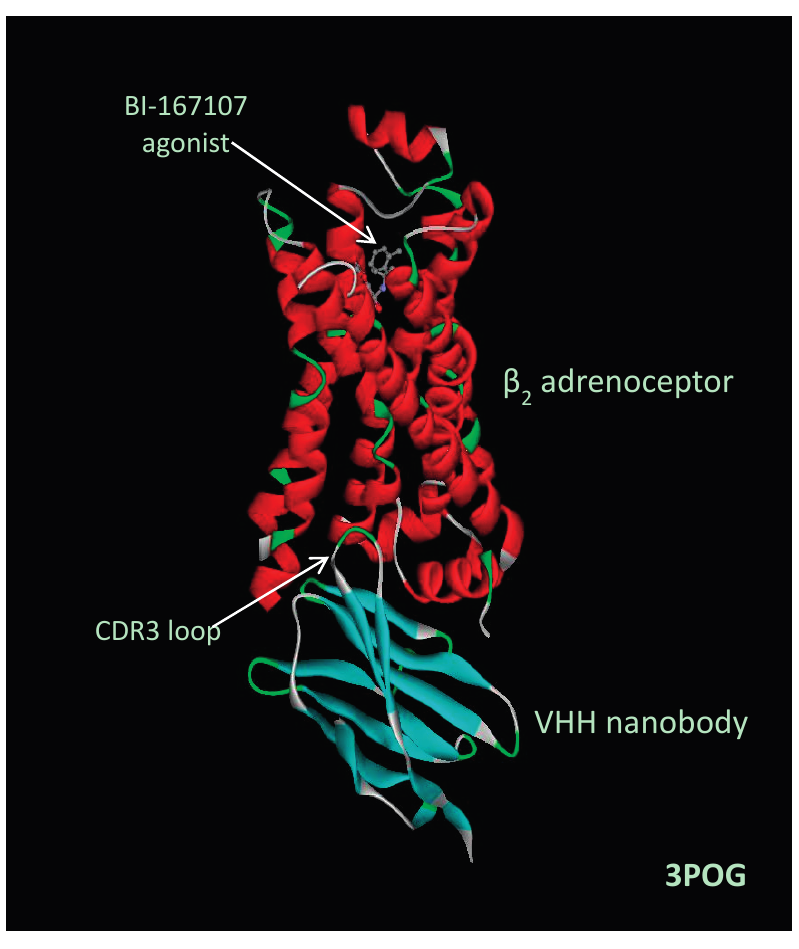
Figure 1. Crystal structure of a nanobody-stabilized active state of the β 2 adrenoceptor (PDB